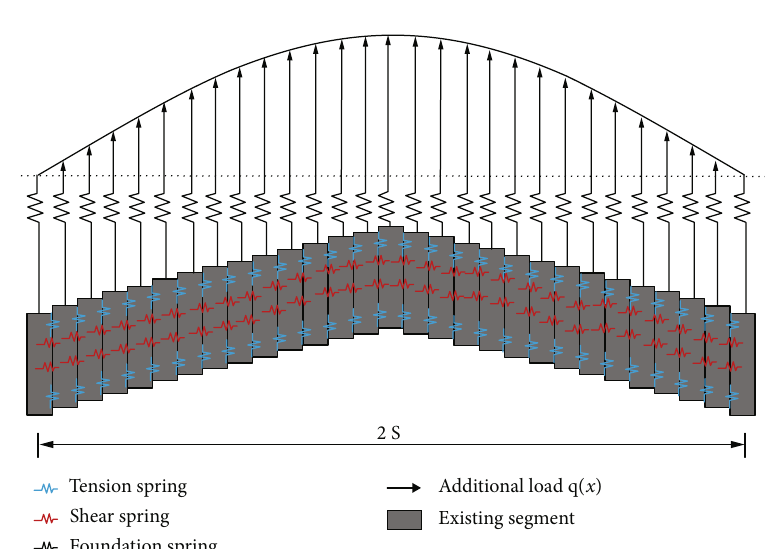
Figure 8: Calculation model of shearing stagger of existing shield